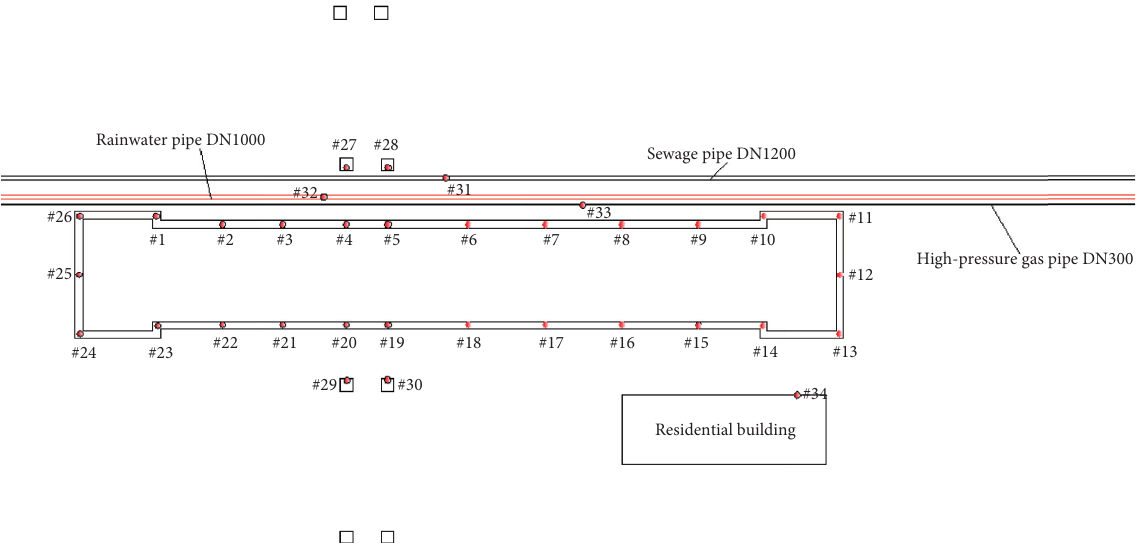
Figure 6: Monitoring the site